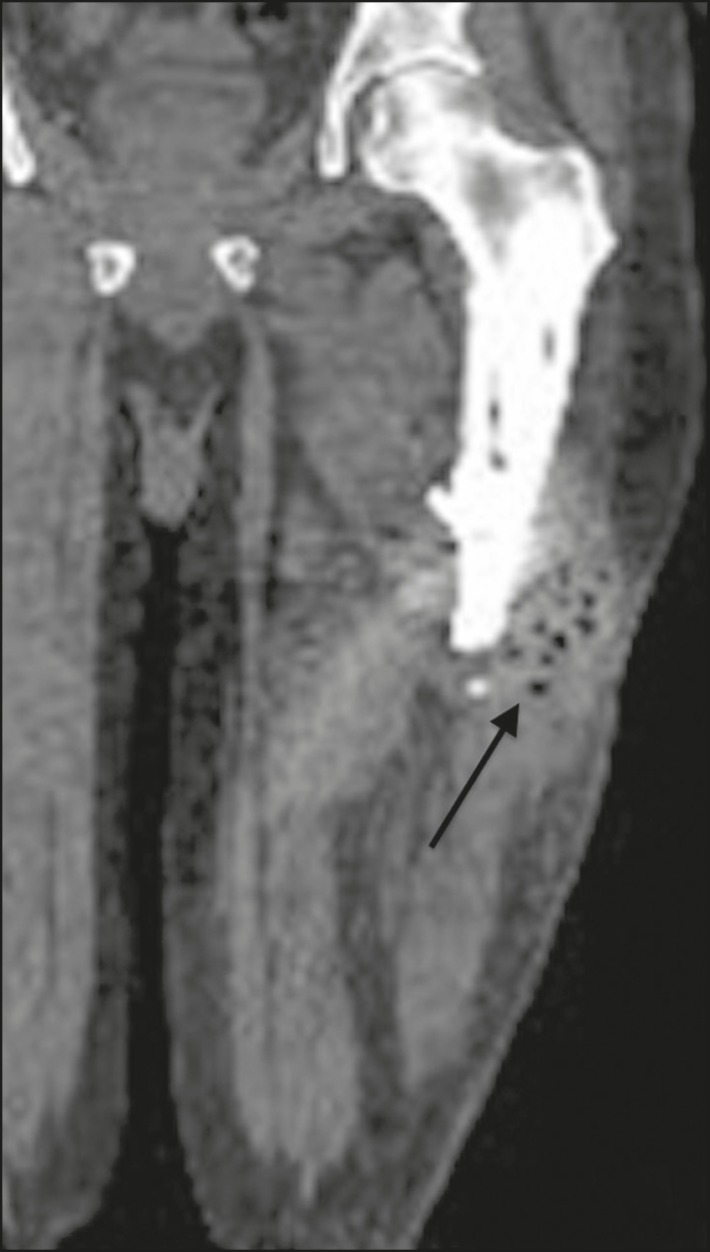
Coronal computed tomography scan of a patient with an infected left femoral prosthesis. Oval formation (arrow), measuring 9.1 × 2.3 cm, containing gas bubbles, located in the middle third of the left thigh, in contact with the femoral stem of the prosthesis, suggestive of abscess.